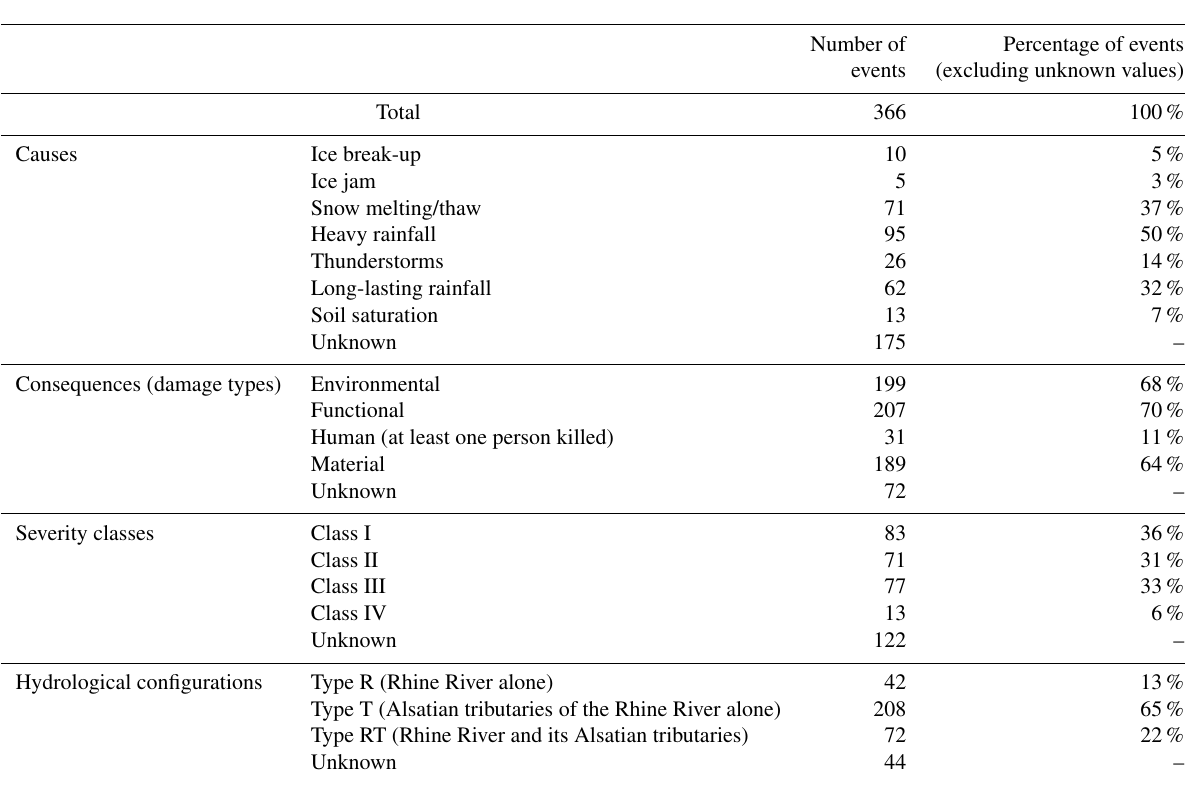
Table 4. Characterization of the ORRION events according to their causes, consequences, severity class, and hydrological configuration. Please refer to text and Tables 2–3 for a full definition of the different